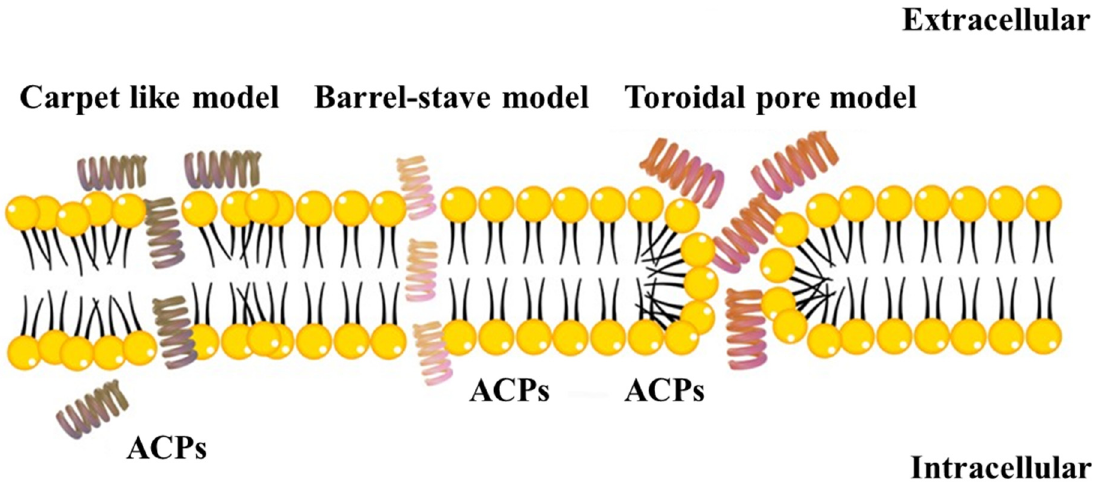
Figure 1. Schematic representation of the most significant models of ACPs action. The yellow circles and the black linkers represent the hydrophilic and hydrophobic regions, respectively, of the phospholipid cell membranes.